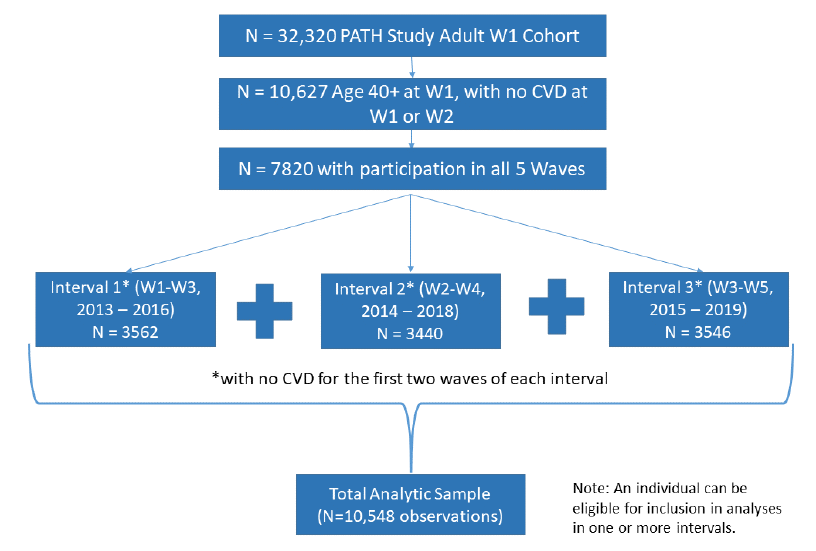
Figure 1. Derivation of Analytic Sample.